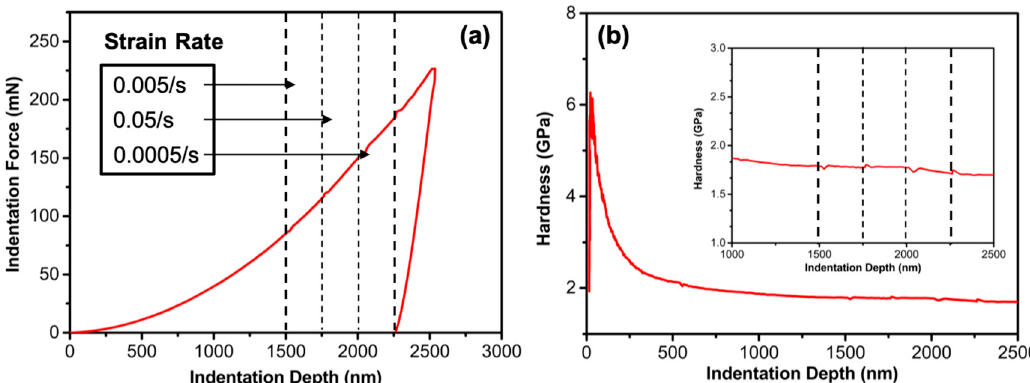
Figure 2. ( a ) Representative indentation force–depth curve of a strain-rate jump test. ( b ) Measured hardness versus indentation depth curve. The insert is a magnified figure of the strain-rate jump regime. The changes in the hardness are highlighted.